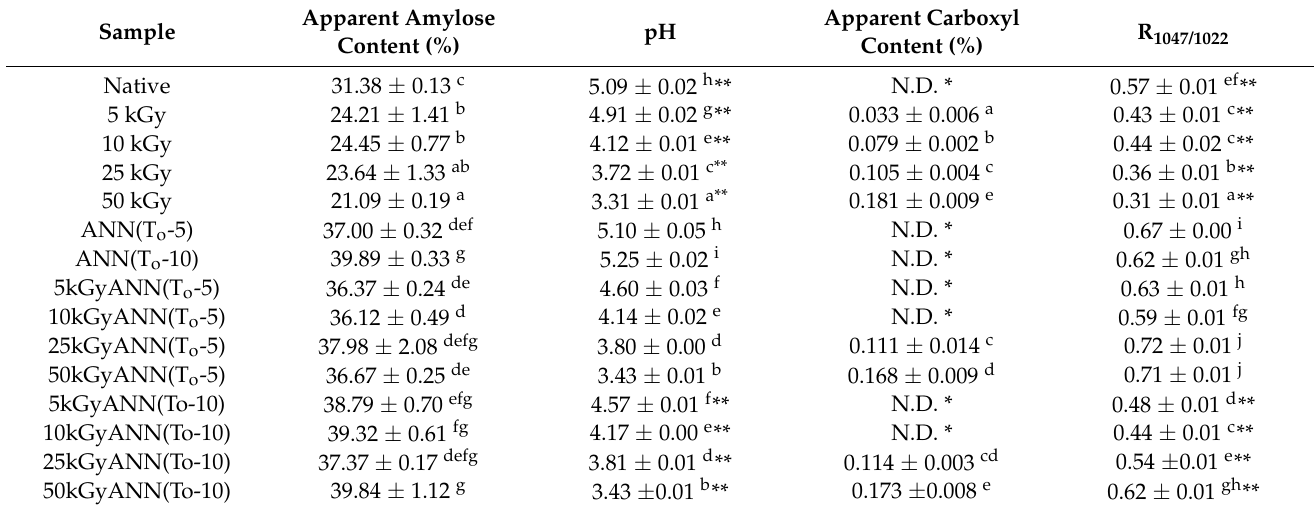
Table 1. The apparent amylose content, pH, apparent carboxyl content, and IR intensity ratio